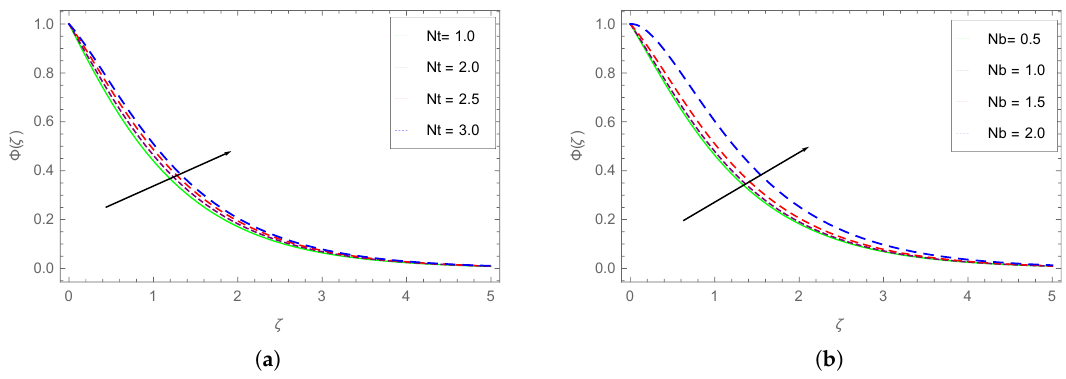
Figure 16. ( a ) Φ ( ζ ) dependence on Nt . ( b ) Φ ( ζ ) dependence on Nb